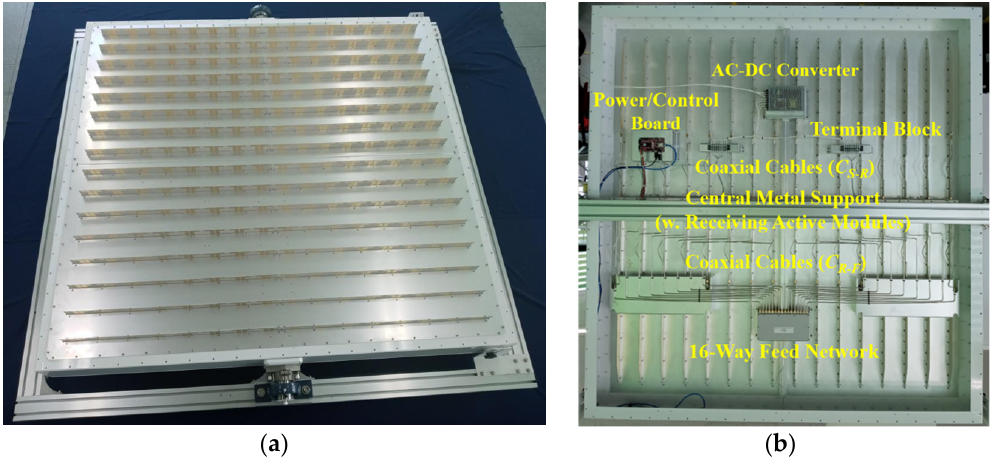
Figure 10. Photos of the implemented phased-array antenna system: ( a ) front view before covering the radome and ( b ) back side view.